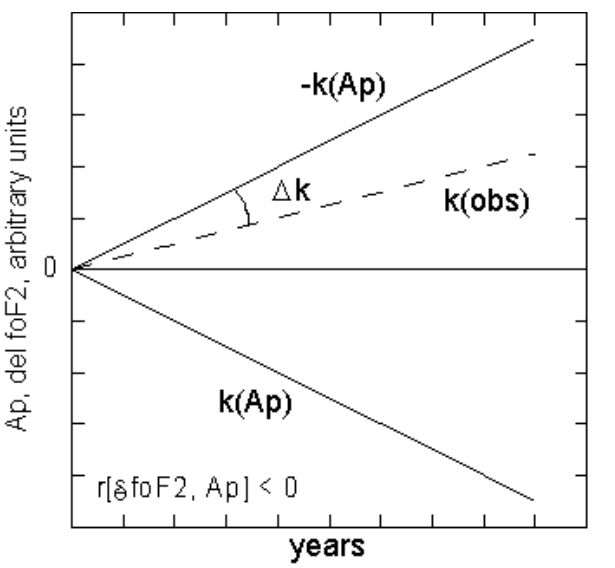
Fig. 4. Variations of the r [ k(tr),k(A p ) ] value as a function of 1k in the vicinity of the r [ k(tr),k(A p ) ] maximum.